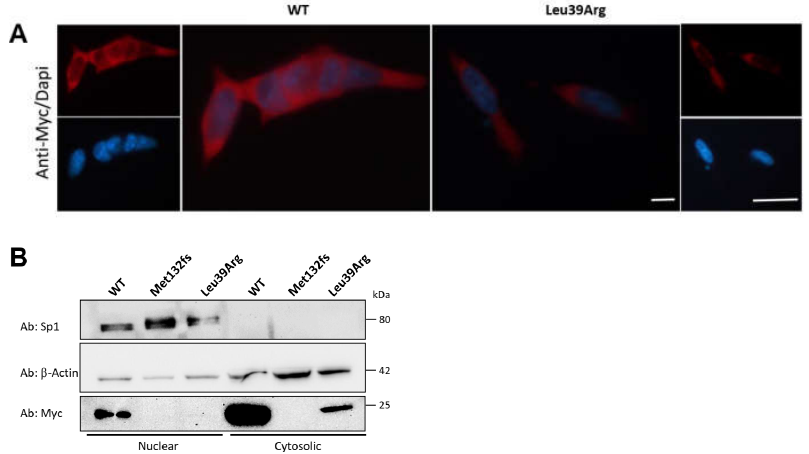
Figure 9. CK2beta cellular localization is not impaired by Leu39Arg mutation. ( A ) Epi-fluorescence microscopy showing the cytosolic localization of CK2beta wild type (WT) and mutant (Leu39Arg) in HeLa cells. The red signals correspond to CK2beta staining, and the blue corresponds to nuclear DAPI staining. Scale bars = 10 µM. ( B ) Nuclear and cytosolic fractions from HeLa cells transfected with wild-type CK2beta or mutants (Leu39Arg and Met132fs) were run on SDS-PAGE. The gel was blotted and probed with an anti-Myc antibody. The blot was probed with anti-β-Actin and anti-Sp1 antibodies as loading controls for cytosolic and nuclear fractions, respectively.